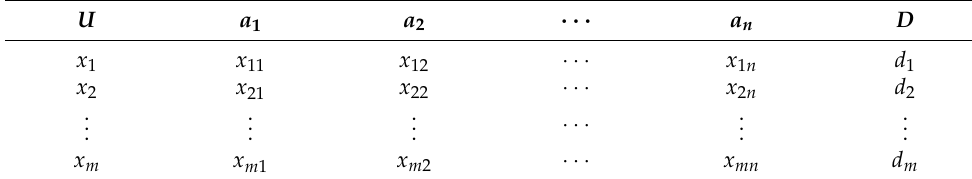
Table 2. A decision-making